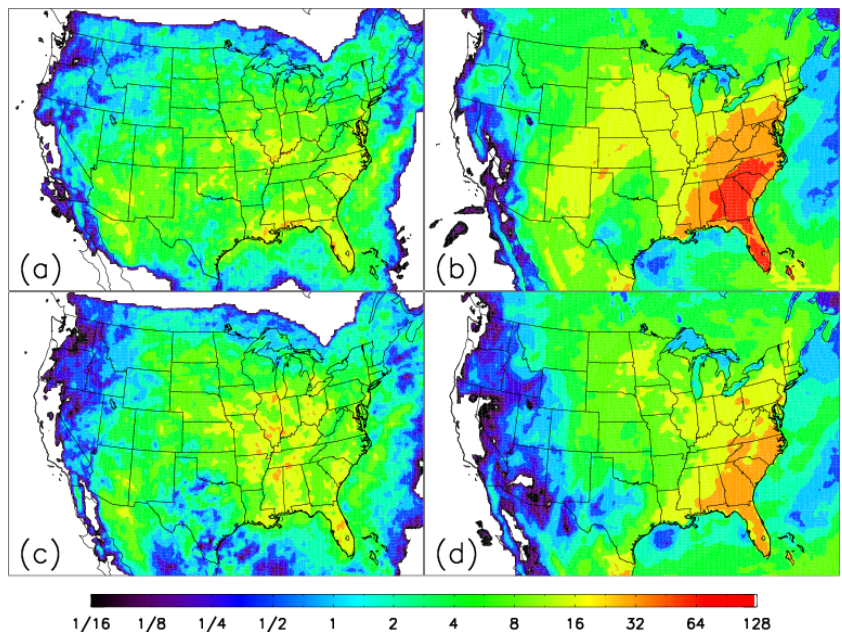
Fig. 4. Total CG flashes in number per km 2 per full-year during JJA 2006 (first row) and 2011 (second row). First column ( a and c ) shows the NLDN observed density gridded to WRF 36 model grid, and second column ( b and d ) shows the modeled flash density output by WRF at 36 km .